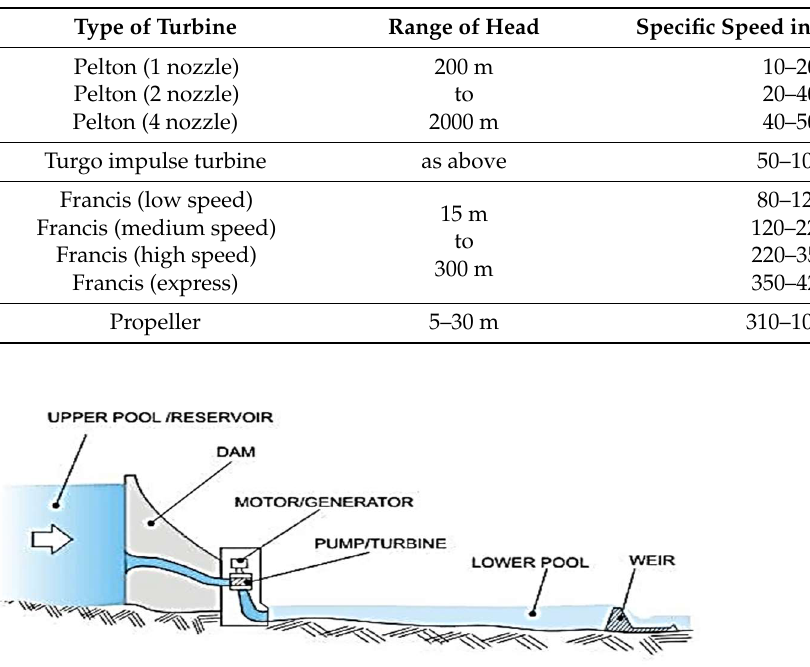
Table 2. Recommended turbine types related to water head [50].